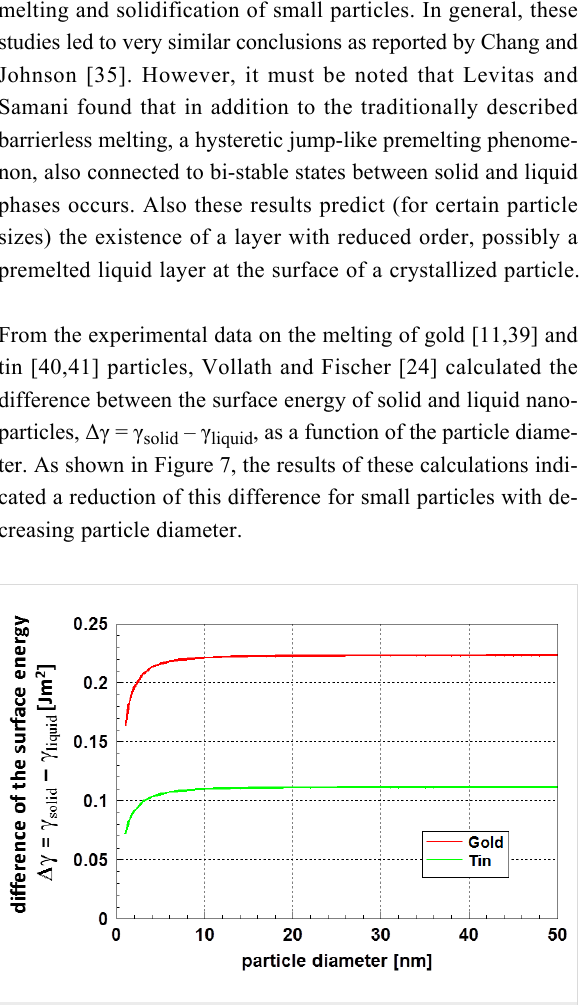
Figure 7: Difference of the surface energy between the solid and the liquid state at the melting temperature of the particles as function of the particle diameter for gold and tin